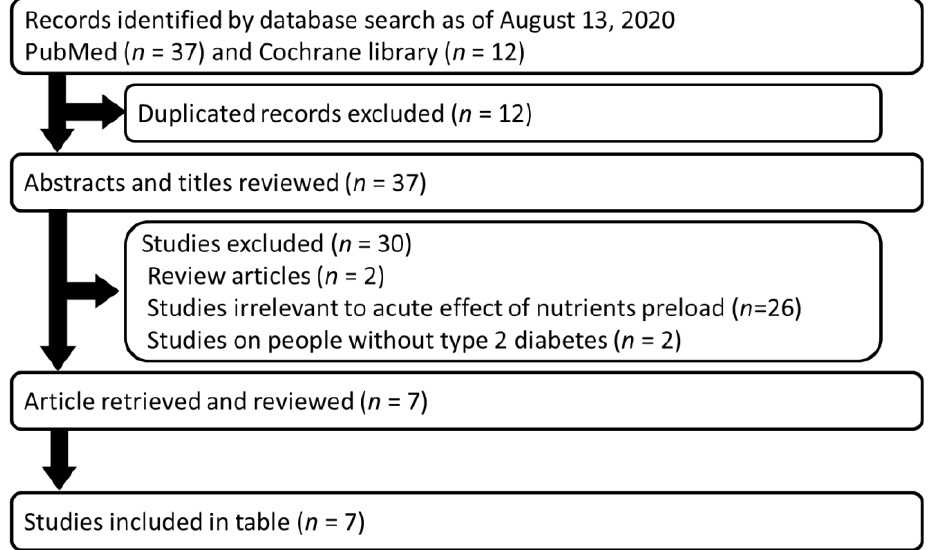
Figure 2. Flow diagram of the systematic review. Relevant articles were searched in PubMed and Cochrane library. The search terms were (Fat OR Protein OR fiber) AND (Preload OR “meal sequence” OR “postprandial glycemia” OR “postprandial glucose” OR “glucose excursion”) AND (“type 2 diabetes”) AND (“glucose - dependent insulinotropic polypeptide”) AND (“glucag on-like peptide- 1”) NOT (Review[pt]). The resulting 37 articles were inspected for their relevancy, and 7 manuscripts are listed in Table 1.